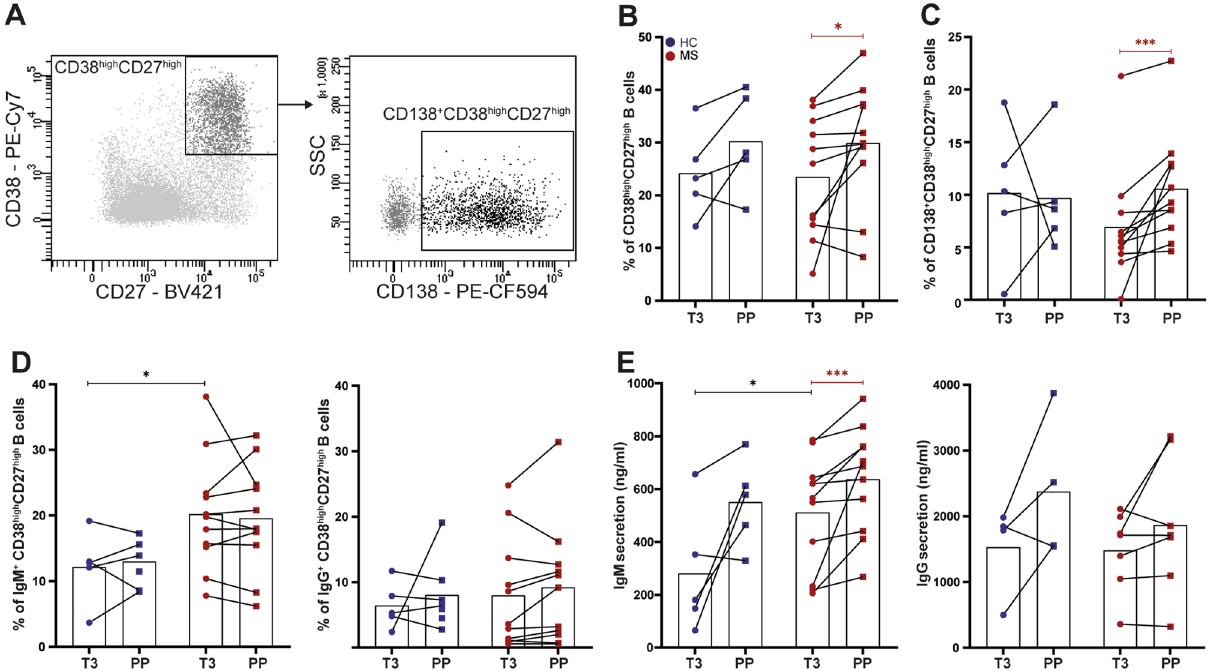
Figure 3. In vitro outgrowth of antibody-secreting cells using memory B cells from paired third trimester and postpartum blood samples. ( A ) Representative gating of CD138-expressing antibody-secreting cells (CD38 high CD27 high ) after culturing of memory B cells under IL-21/CD40L-stimulating (T FH -like) conditions for 6 days. Fractions of CD38 high CD27 high plasmablasts/plasma cells ( B ), CD138 + CD38 high CD27 high plasma cells ( C ) and IgM + and IgG + CD38 high CD27 high plasmablasts ( D ; FACS), as well as IgM and IgG secretion ( E ; ELISA) were compared between cultures with third trimester (T3) and postpartum (PP) memory B cells from 11 MS patients (red) and 5 HC (blue). Wilcoxon signed-rank test was performed to compare third trimester and postpartum samples. Two-way ANOVA was performed to compare MS and HC groups. * p < 0.05, *** p <